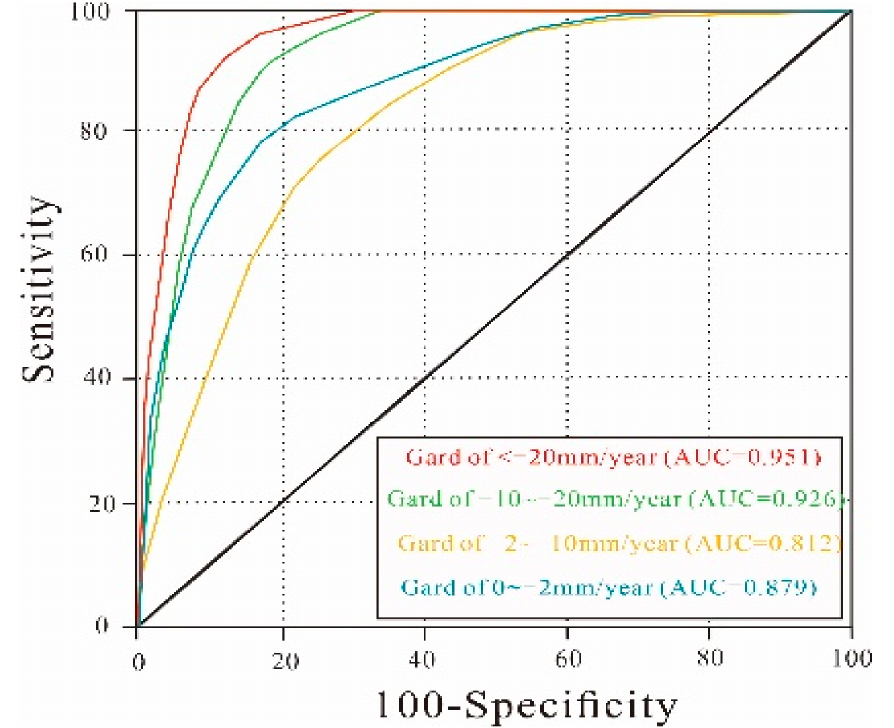
Figure 10. The ROC curves for the Land subsidence susceptibility maps at different land subsidence intensities and their